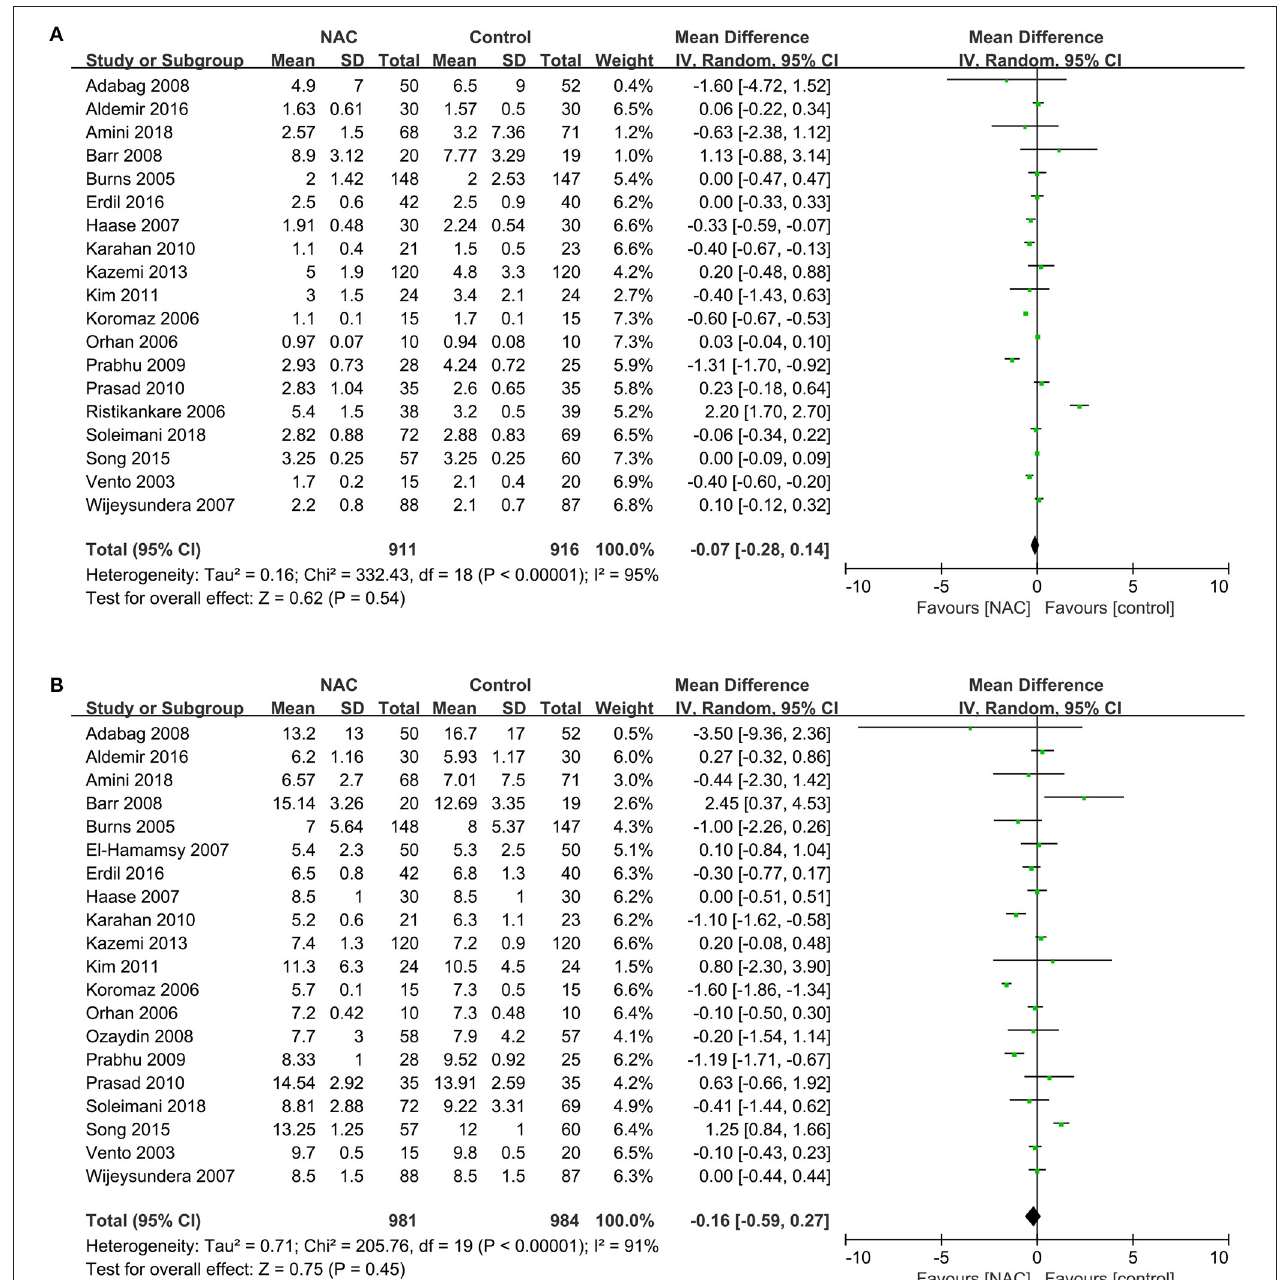
FIGURE 7 | Forest plot of the effects of NAC on the length of stay in ICU and hospital. (A) Forest plot of the length of stay in ICU. (B) Forest plot of the length of stay in hospital.